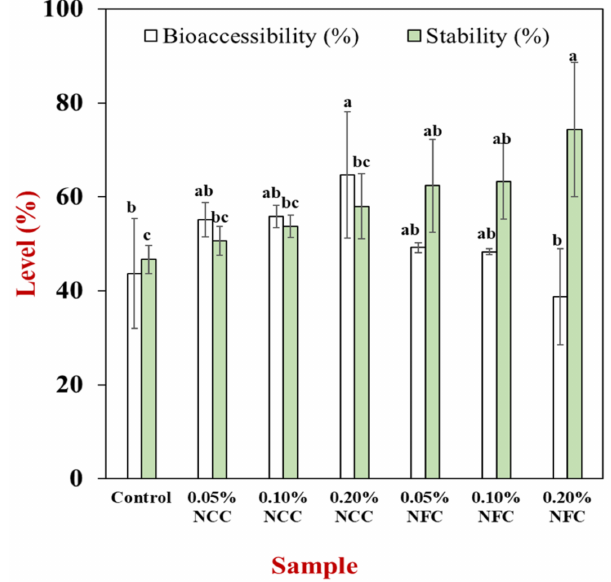
Figure 9. Influence of nanocellulose type and concentration on β -carotene stability and β -carotene bioaccessibility of 10% ( w / w ) O/W emulsions containing β -carotene stabilized by either nanocrys- talline cellulose or nanofibrillated cellulose (NFC) at various concentrations. Samples designated with different lowercase letters (a − c) were significantly different (Duncan, p <